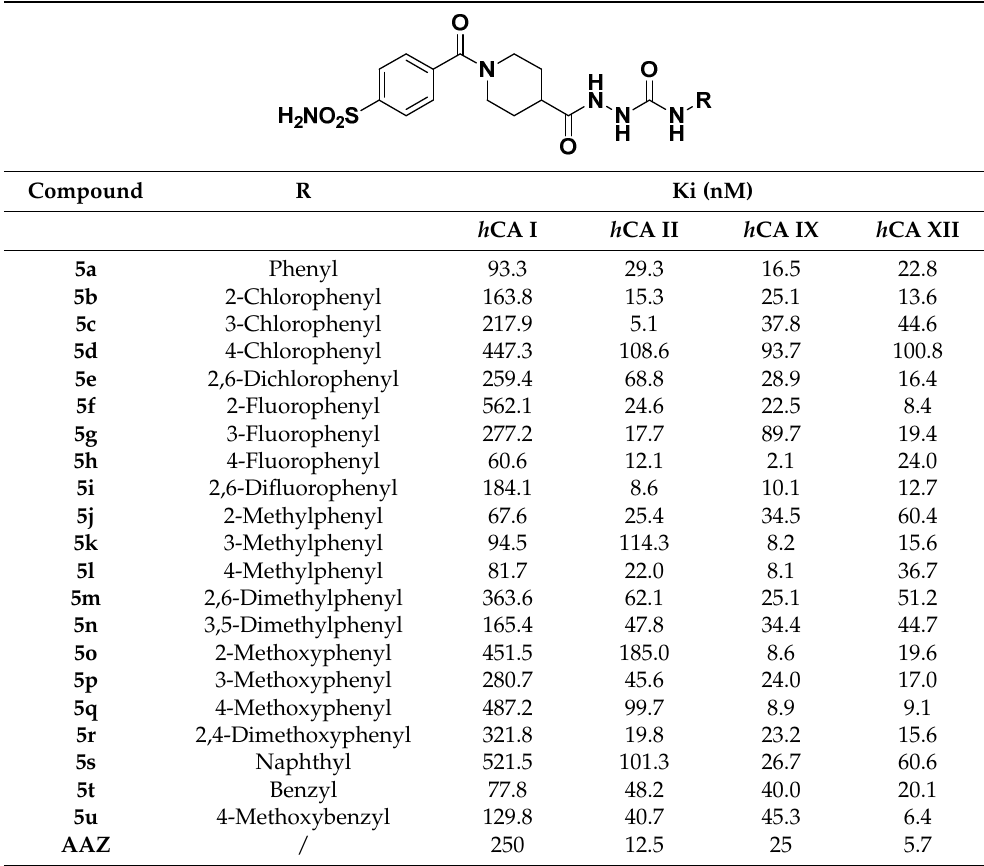
Table 1. Inhibition data of human CA isoforms CA I, II, IX and XII with sulfonamides 5a – u reported here and the standard sulfonamide inhibitor acetazolamide (AAZ) by a stopped flow CO 2 hydrase assay [23].